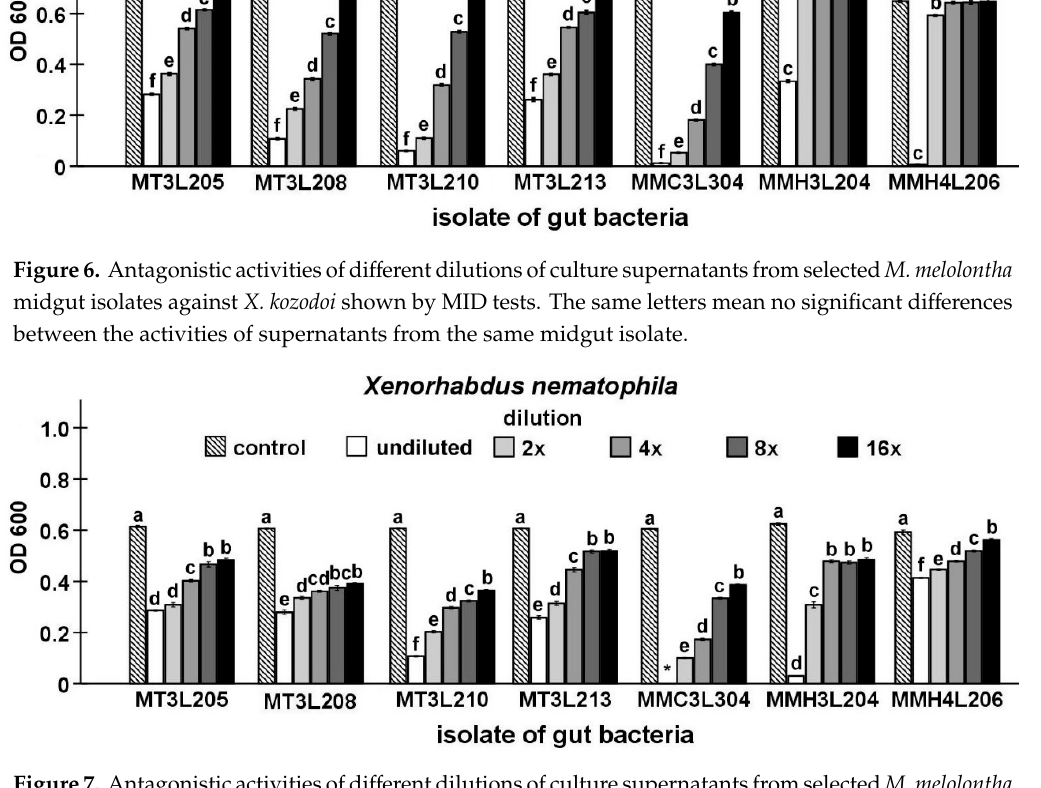
Figure 7. Antagonistic activities of different dilutions of culture supernatants from selected M. melolontha midgut isolates against X. nematophila shown by MID tests. The same letters mean no significant differences between the activities of supernatants from the same midgut isolate. *—no bacterial growth.